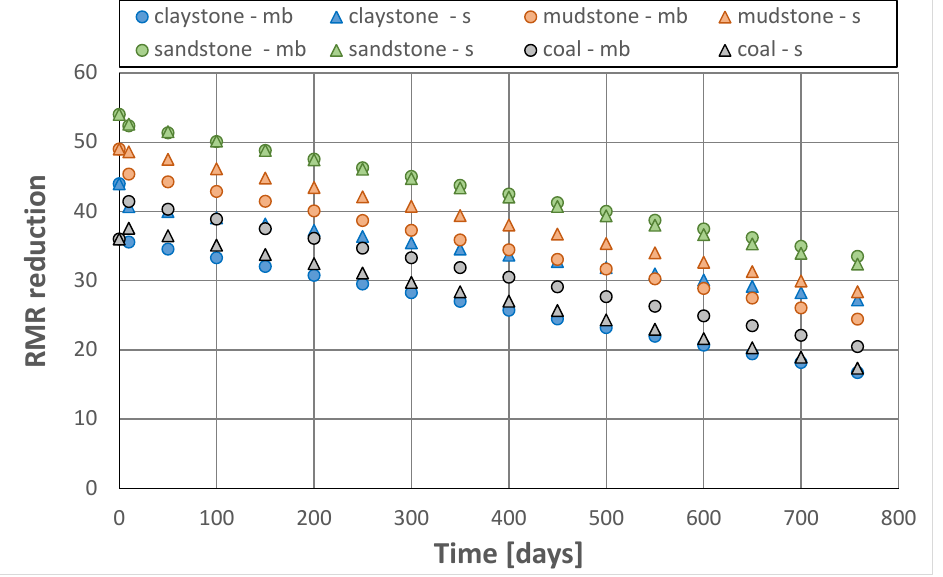
Figure 13. RMR decrease corresponding to m b and s decrease versus time—rocks around roadway D-2.